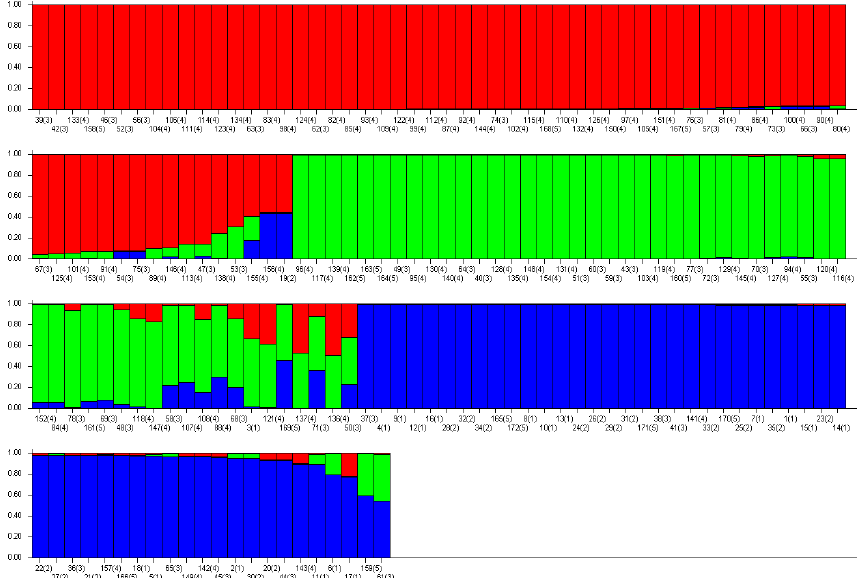
Figure 3. Model-based membership of 172 Korean soybean varieties using STRUCTURE. Colors represent model-based sub-populations as follows: red, Pop. 1; lime, Pop. 2; and blue, Pop. 3.